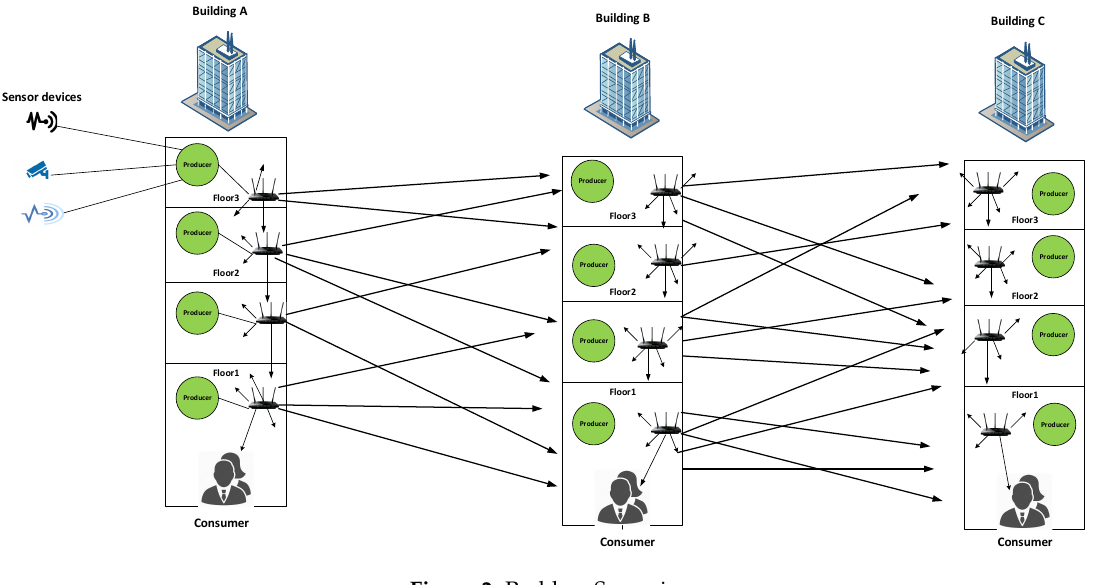
Figure 2. Problem